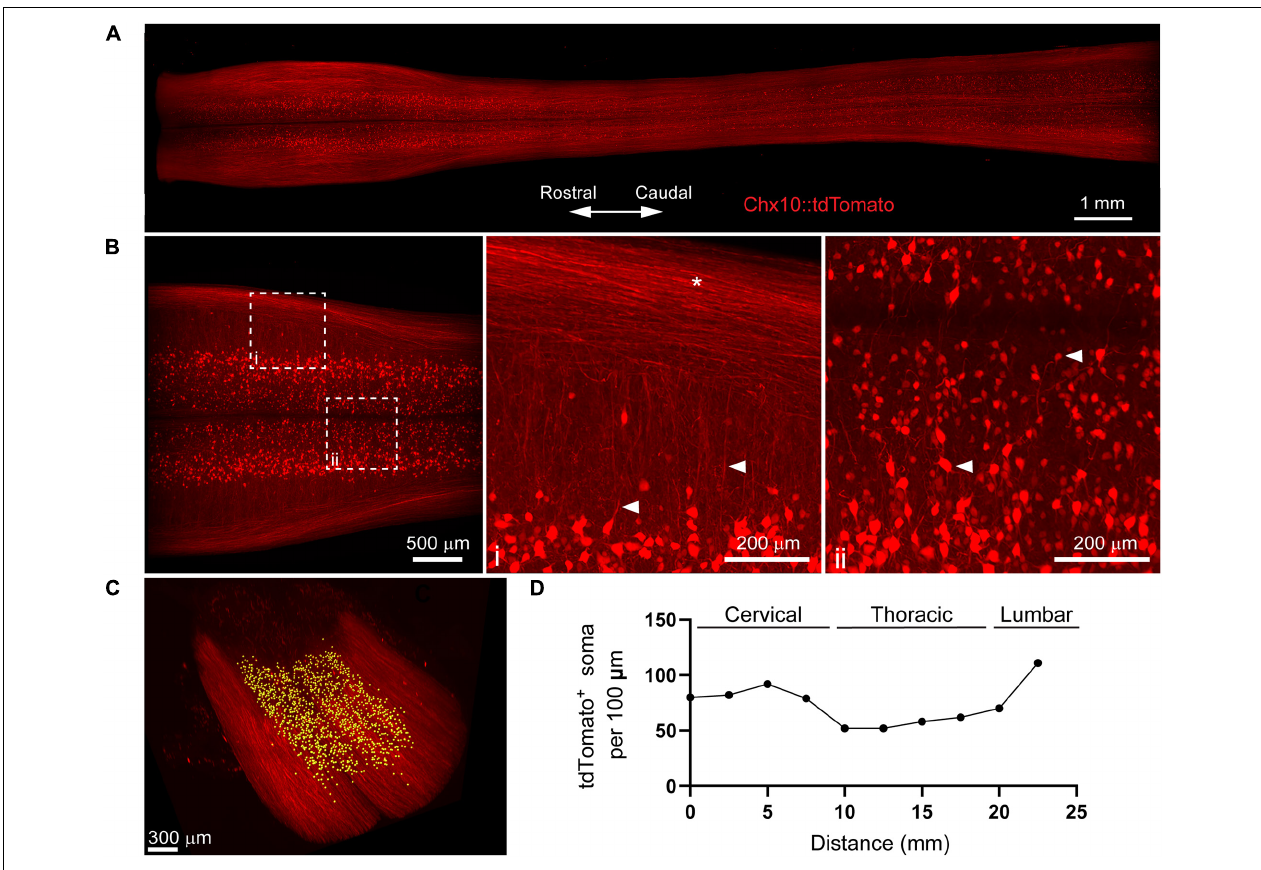
FIGURE 2 | PACT clearing preserves endogenous tdTomato fluorescence in spinal cord interneurons for 3D imaging of neural circuits. (A) Maximum intensity projection of tdTomato in V2a interneurons in the cleared spinal cord from a Chx10:tdTomato mouse. (B) Maximum intensity projection of the intermediate zone from a single field of view of the cleared spinal cord showing V2a interneuron soma. Axons from V2a interneurons project laterally in the grey matter before extending along white matter tracts ( i ; arrows and asterisk, respectively). Large and small soma can be easily identified ( ii , arrows) in the grey matter. (C) V2a interneuron soma counting in Imaris (yellow dots). (D) Average number of V2a interneurons per 100 µ m assessed every 2.5 mm along the length of the spinal cord ( n =